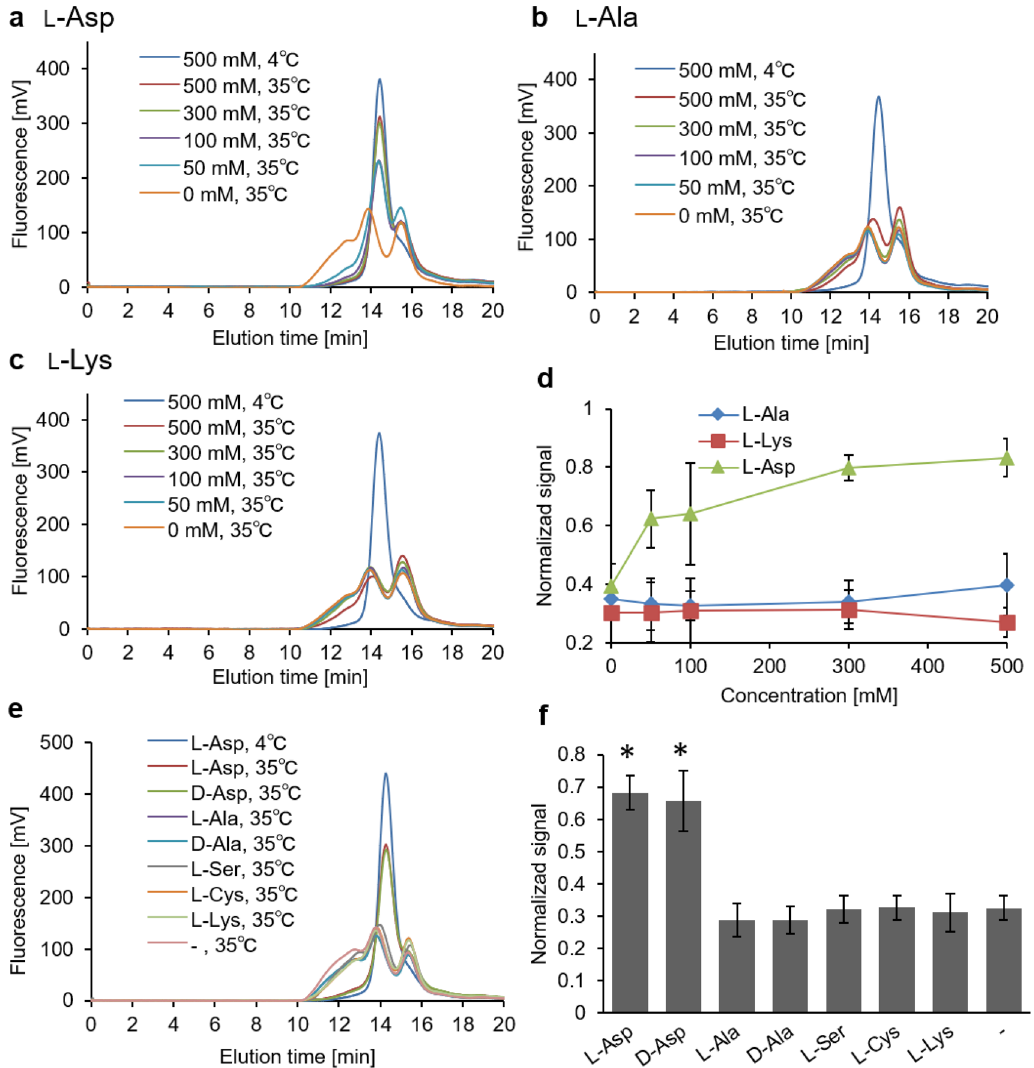
Figure 4. Substrate concentration dependance and its specificity for the thermal stability of AspT. Purified AspT was heat treated at 4°C or 35°C for 10 min in the presence of 0 to 500 mM of l-Asp ( a ), l-Ala ( b ), or l-Lys ( c ). After ultracentrifugation at 190,000 g for 30 min at 4°C to remove aggregated AspT, the supernatant was subjected to size-exclusion chromatography and the tryptophan fluorescence of AspT was observed with a fluorescence detector. The fluorescence intensities relative to that of undenatured AspT, taking the peak height of purified AspT without heat treatment as 1, are shown in ( d ). ( e ) Purified AspT was heat treated at 35°C for 10 min in the presence of 100 mM substrate or analog. The fluorescence intensities relative to that of undenatured AspT, taking the peak height of purified AspT without heat treatment as 1, are shown in ( f ). * P < 0.05, Tukey’s